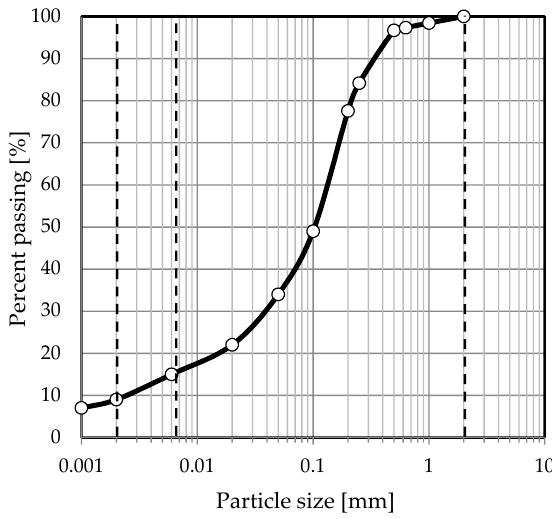
Figure 1. Grain size distribution curve of soil binder. Table 2. Properties of blast furnace cement.